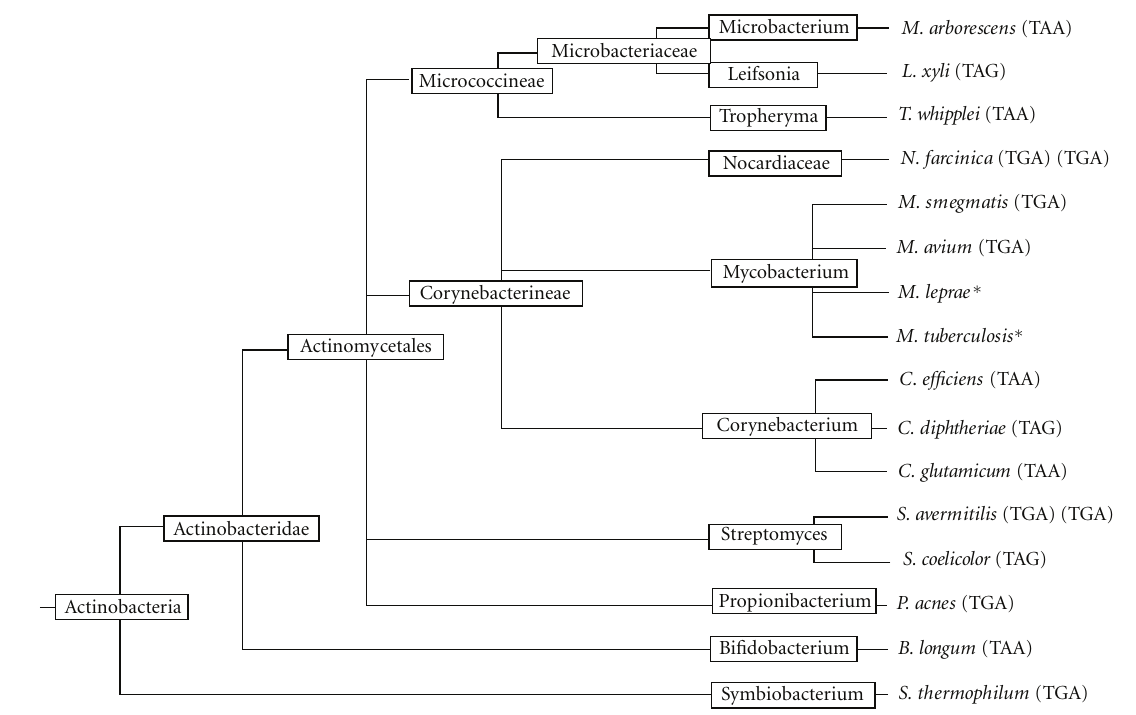
Figure 3: The Actinobacterial species and the stop codons used in their dps -like genes. The names of the classes were given in boxes at braches of the phylogenetic tree. Stop codons in dps- like genes were shown in brackets. Asterisks indicate no dps -like gene has been detected. Double brackets mean there are two copies of dps-like genes in the same